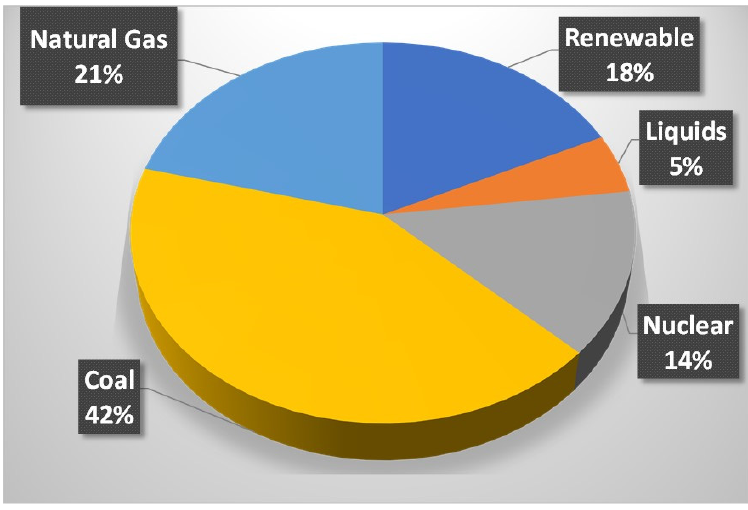
Figure 2. Worlds’ electricity generation